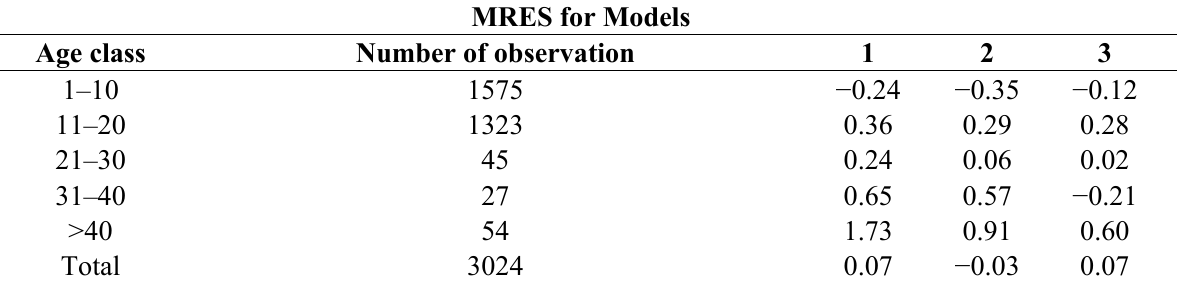
Table 3. Average differences (MRES), m, according to age classes for models